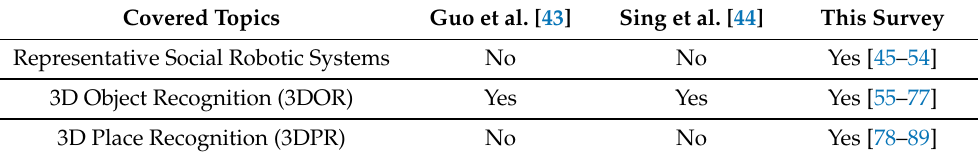
Table 1. The Contributions of This Survey. Covered Topics Representative Social Robotic